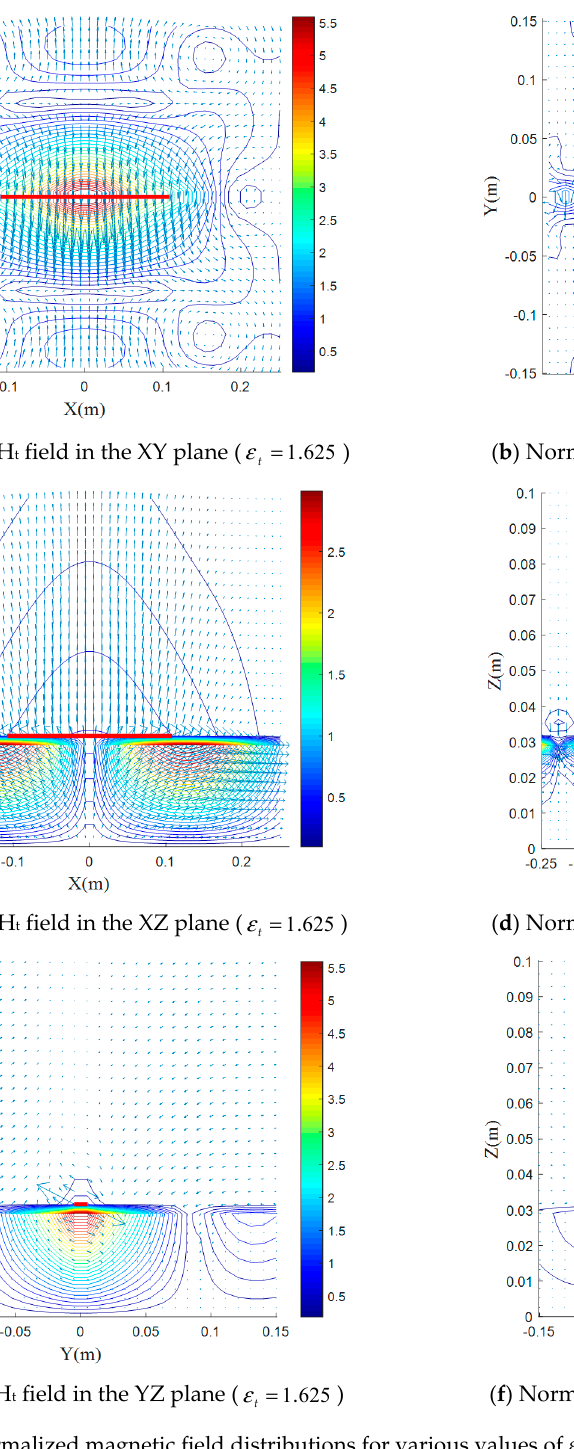
Figure 7. ( a – f ) Normalized magnetic field distributions for various values of ε t with ε z = 3.25, µ z = 1 and µ t = 1 in the XY, XZ, and YZ planes.